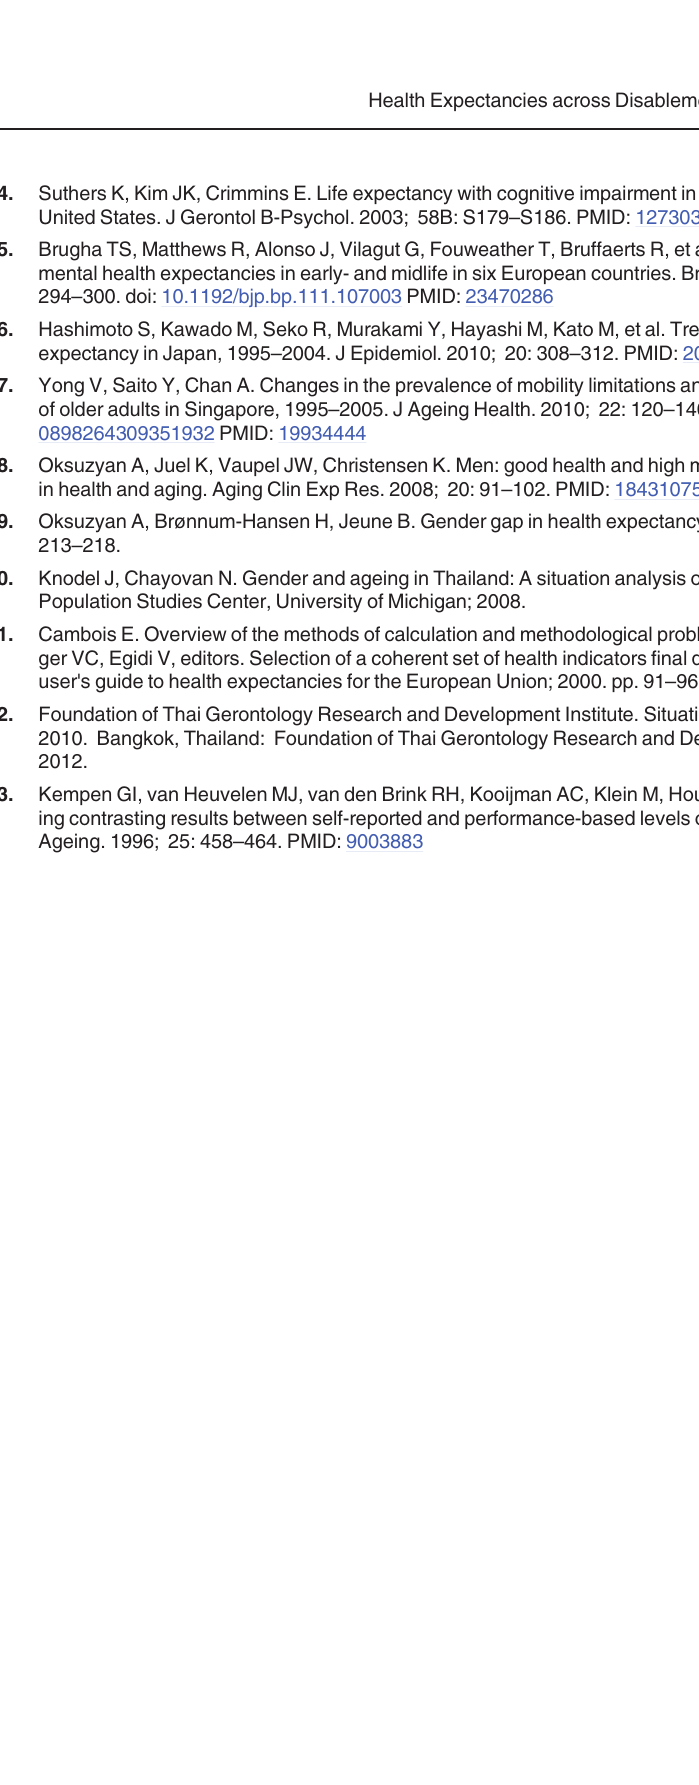
PLOS ONE | DOI:10.1371/journal.pone.0121310 March 23,